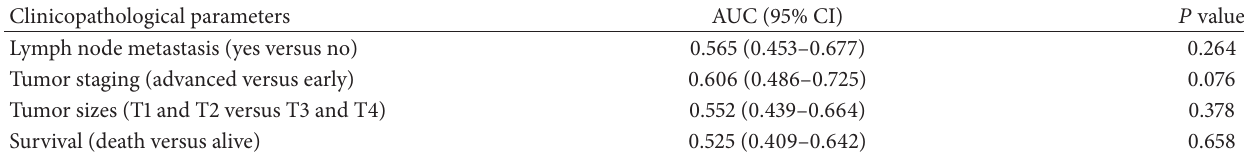
Table 1: Area under the receiver operating characteristic curve (AUC) for each clinicopathological